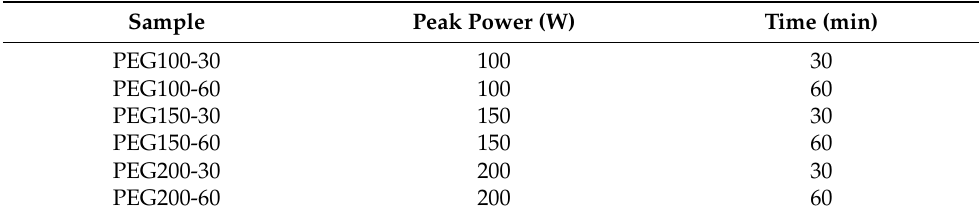
Table 1. Peak powers and times used in the PEG polymerization plasma